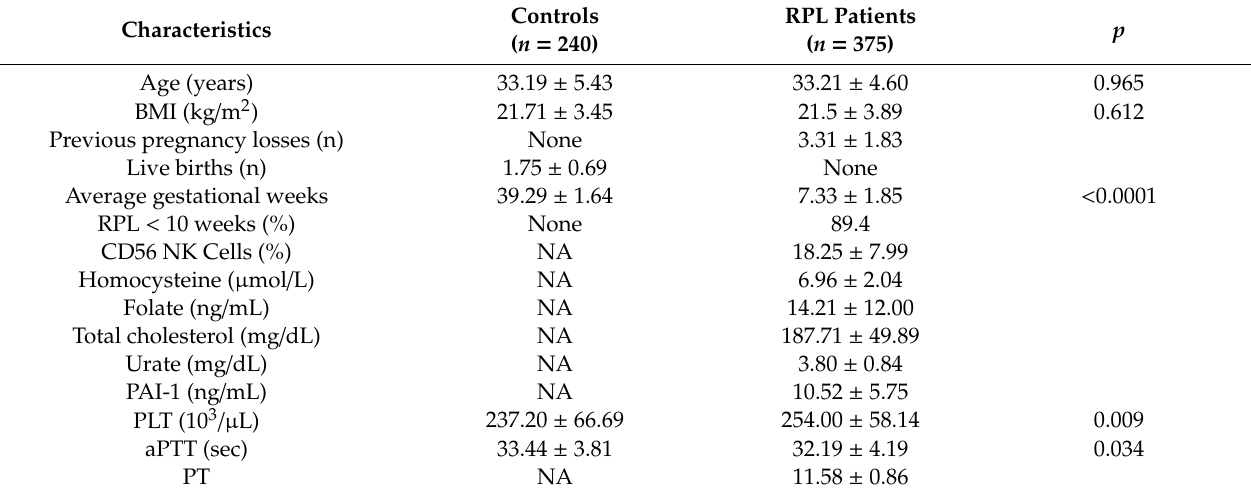
Table 1. Baseline clinical and laboratory profiles of the recurrent pregnancy loss (RPL) patients and control